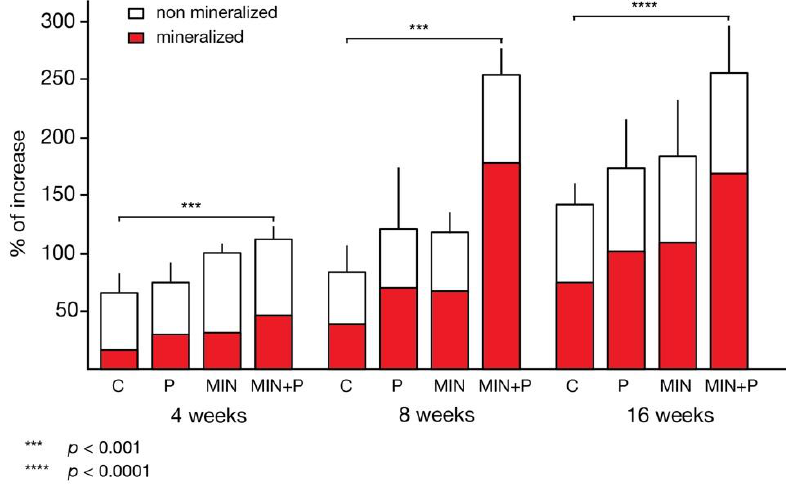
Figure 4. Increase in bone thickness over time. Both the perforation procedure and minocycline administration resulted in an increase in bone thickness, with the strongest effect in the combination of both. This effect was observable at all time points. A large percentage of the newly generated bone was mineralised (red colour; *** p < 0.001; **** p <